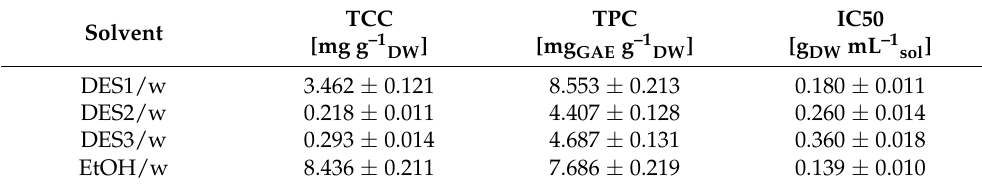
Table 2. TCC, TPC, and IC50 values measured in C. vulgaris extracts obtained at T = 60 ◦ C, r = 20:1 g SW g − 1 DW, and t = 3 h using the DES-based solvents and EtOH/w. The acronym SW stands for solvent weight, and DW for dry weight